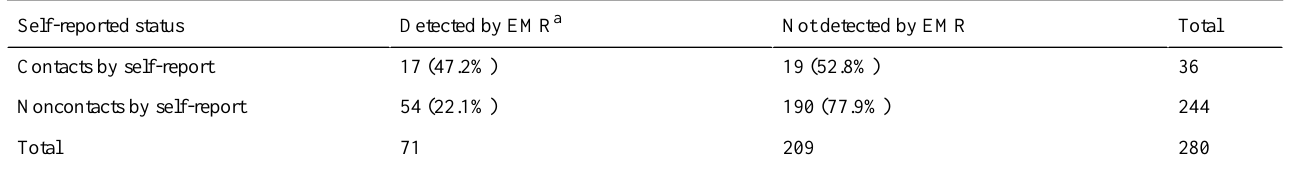
Table 3. Comparison of the performance of EMR-based contact tracing against self-reported contacts with patients with COVID-19. Percentages are calculated according to row